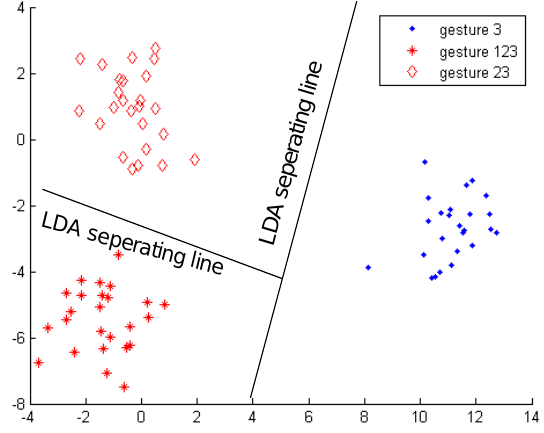
Figure 11. Classifier 3 in the second-level of the first subject.